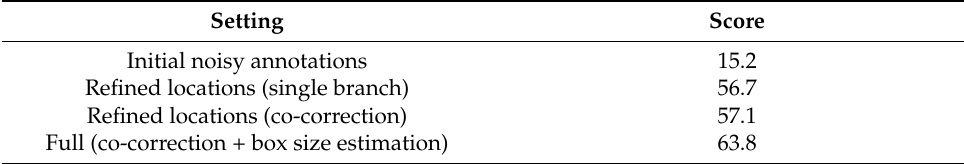
Table 3. Ablation study on NWPU VHR-10 with scores for the quality of annotations obtained in different settings. The scores are the percentages of boxes having an IoU of at least 0.5 with their corresponding ground truth